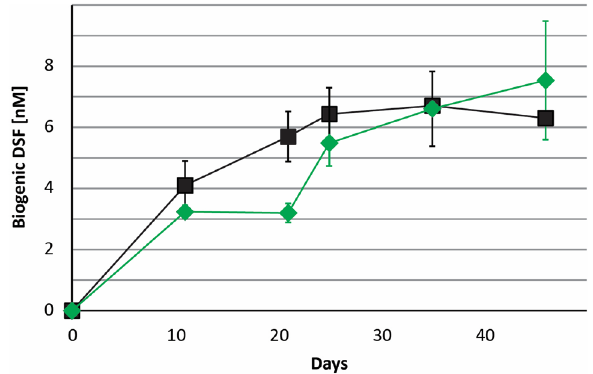
Figure 4. Development of DSF concentrations in Leptospirillum spp . culture supernatants. Concentration of biogenic DSF in cultures of L. ferrooxidans T (black boxes) and L. ferriphilum T (green diamonds) as calculated